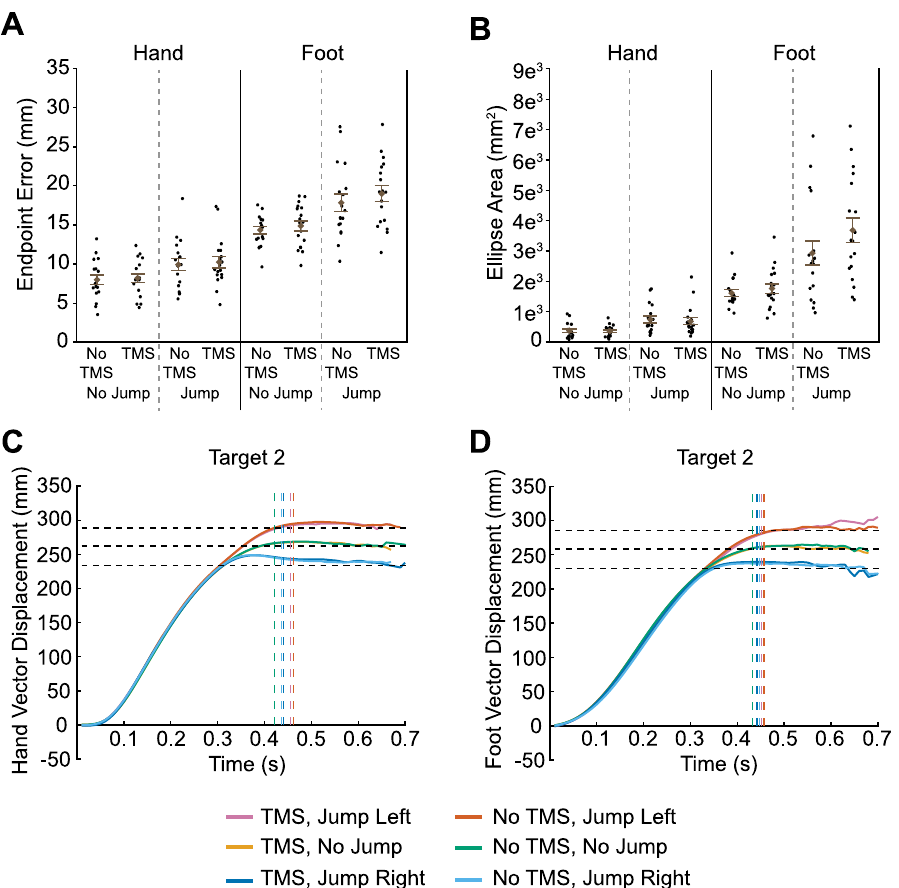
Fig 4. Results of transcranial magnetic stimulation (TMS) to handIPS. Euclidean endpoint error (A) and ellipse area based on endpoint error (B) for hand and foot reaches across all conditions. Filled circles represent mean data from each individual participant. Group mean ± SE is also shown. Hand (C) and foot (D) trajectories towards target two are shown for each condition. Horizontal dashed lines represent the final position of the target (jump left, no jump, and jump right). Vertical dashed lines indicate the average time at which the finger or toe contacted the touchscreen for each condition.